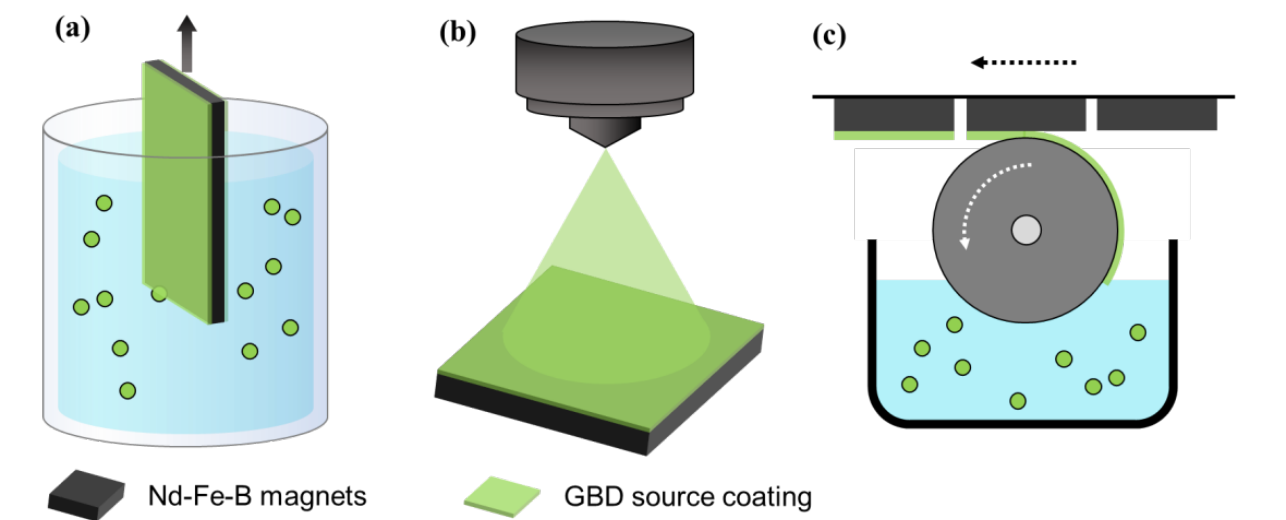
Figure 6. Schematics of ( a ) dipping, ( b ) spraying, and ( c ) roller coating methods for GBD sources.